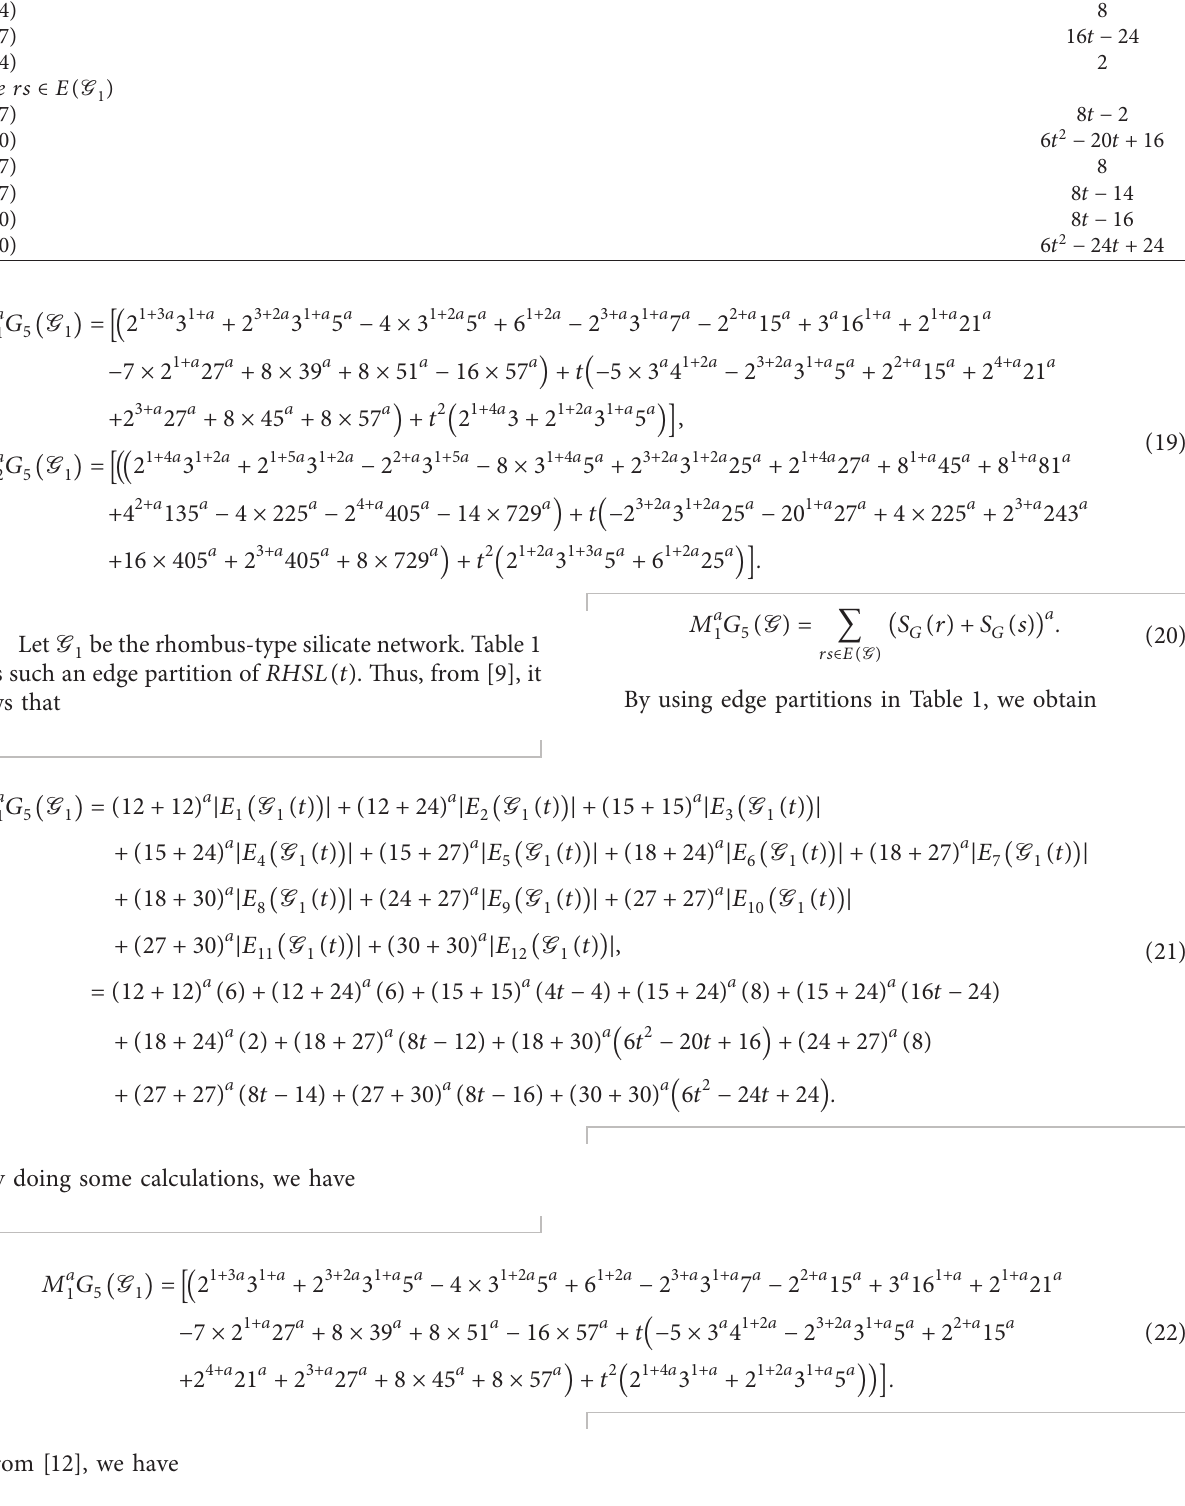
Table 1: Edge partition of rhombus-type silicate network ( RHSL ( t ) ) based on sum of degrees of end vertices of each edge. , S ) Number of edges ( S r s ) Where rs ∈ E ( G 1 ( 12 , 12 ) 6 ( 12 , 24 ) 6 ( 15 , 15